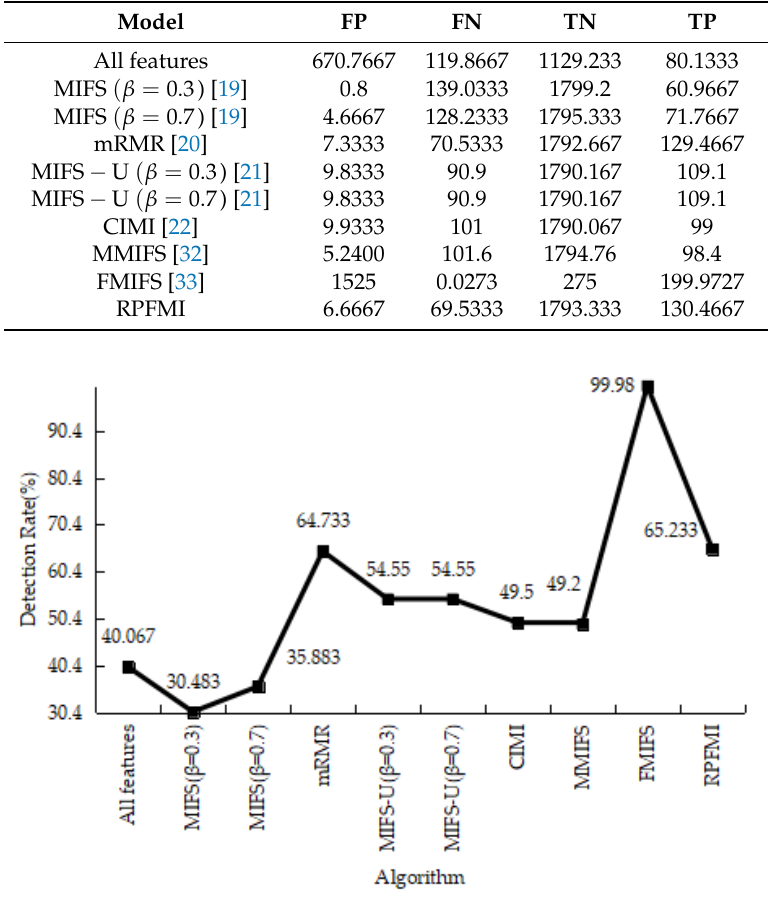
Figure 6. Detection Rate on the U2R test data.